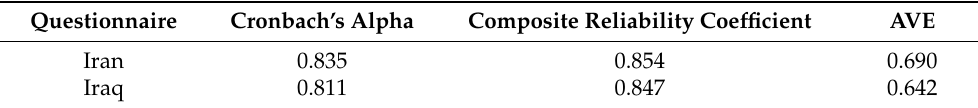
Table 4. The Reliability and validity findings of the research.